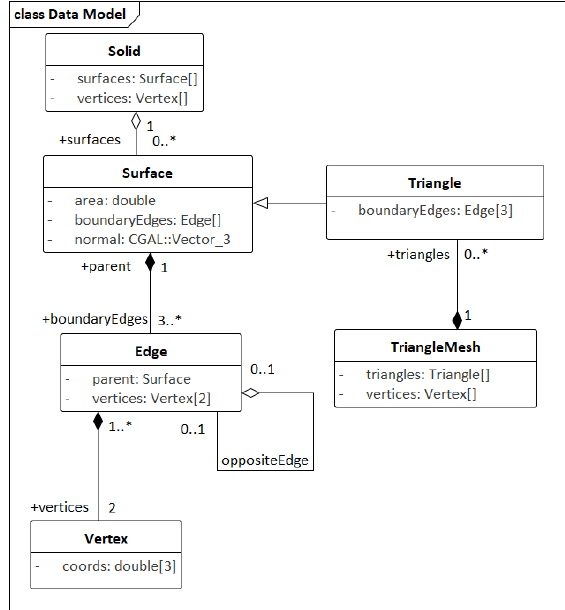
Figure 9. Data model for construction procedure